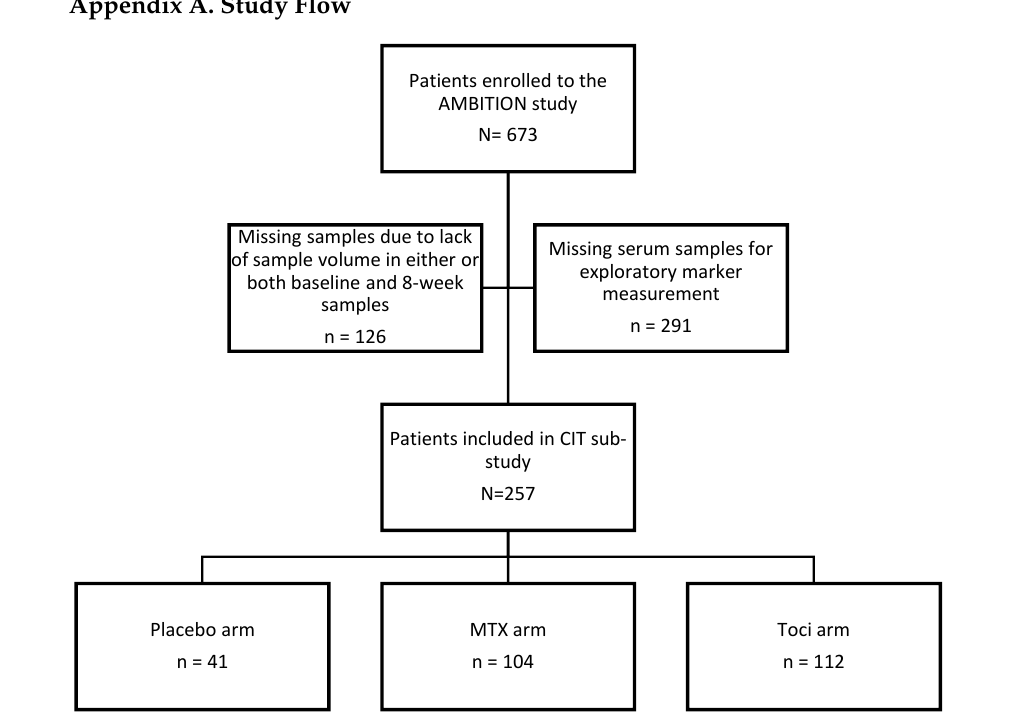
Figure A1. Patients included in the biomarker sub-study and their randomization into three differ- ent arms.